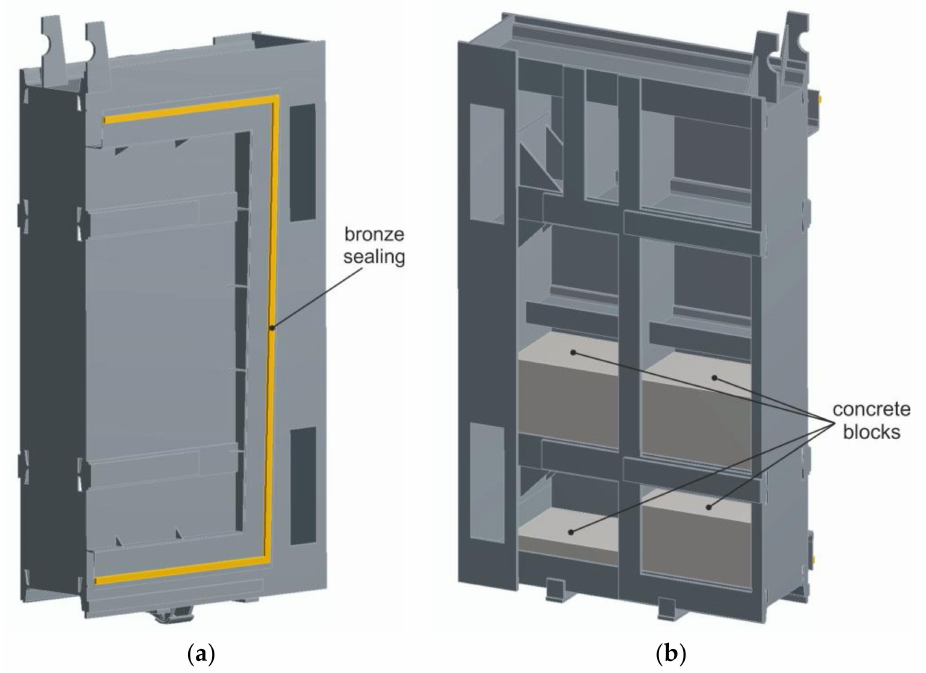
Figure 18. Model of the sluice gate: ( a ) from the side of the connecting water tunnel and ( b ) from the side of the water